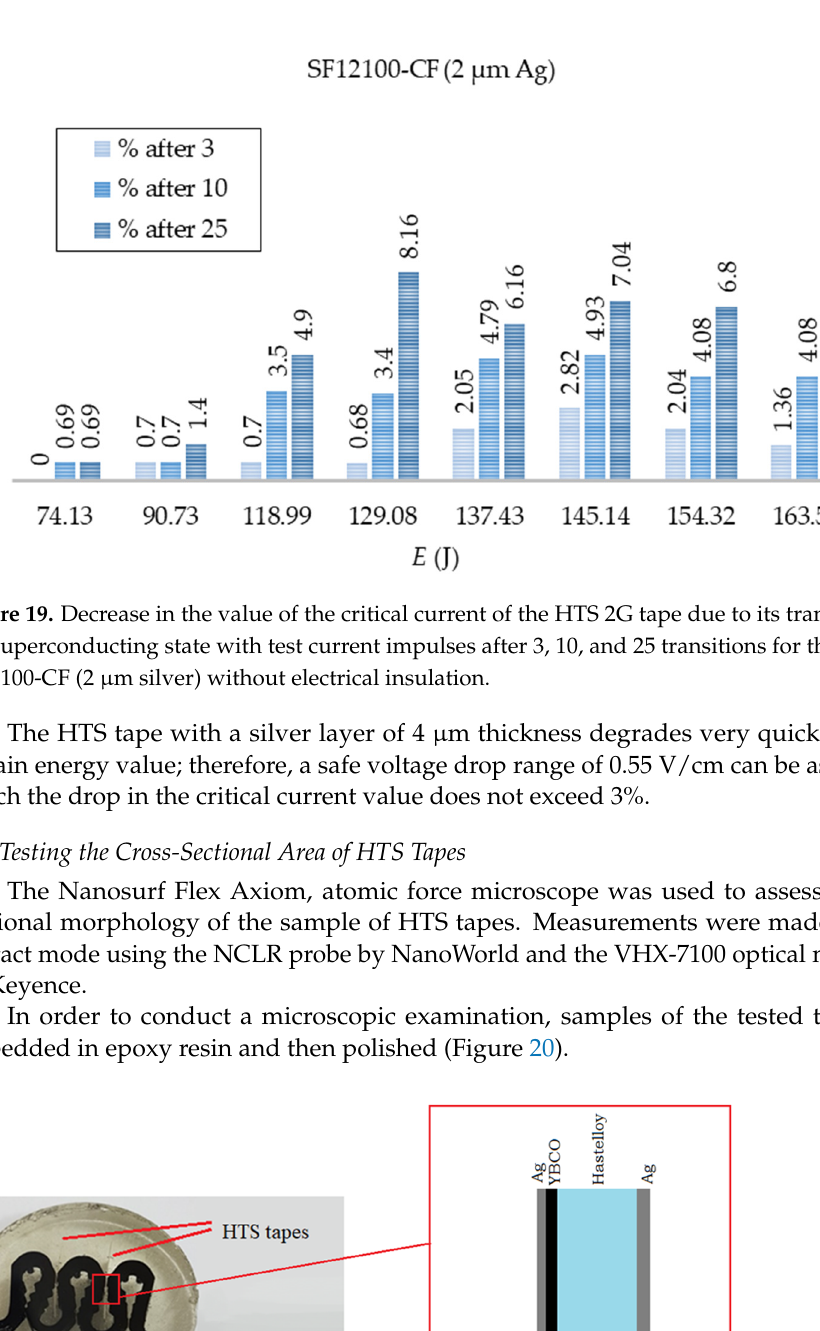
Figure 18. Decrease in the value of the critical current of the HTS 2G tape due to its transition from the superconducting state with test current impulses after 3, 10, and 25 transitions for the HTS tape SF12100-CF (4 μ m silver) without electrical insulation.